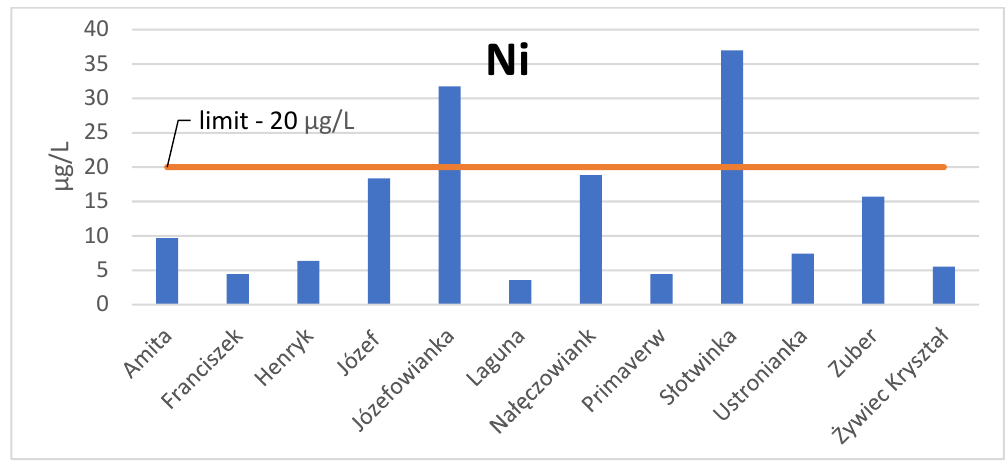
Figure 11. The concentration of nickel in mineral waters ( μg/L ).